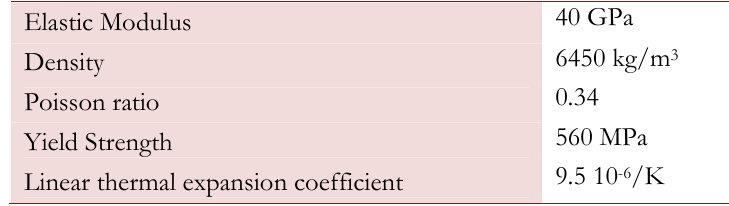
Table 1: Ni-Ti Alloy main